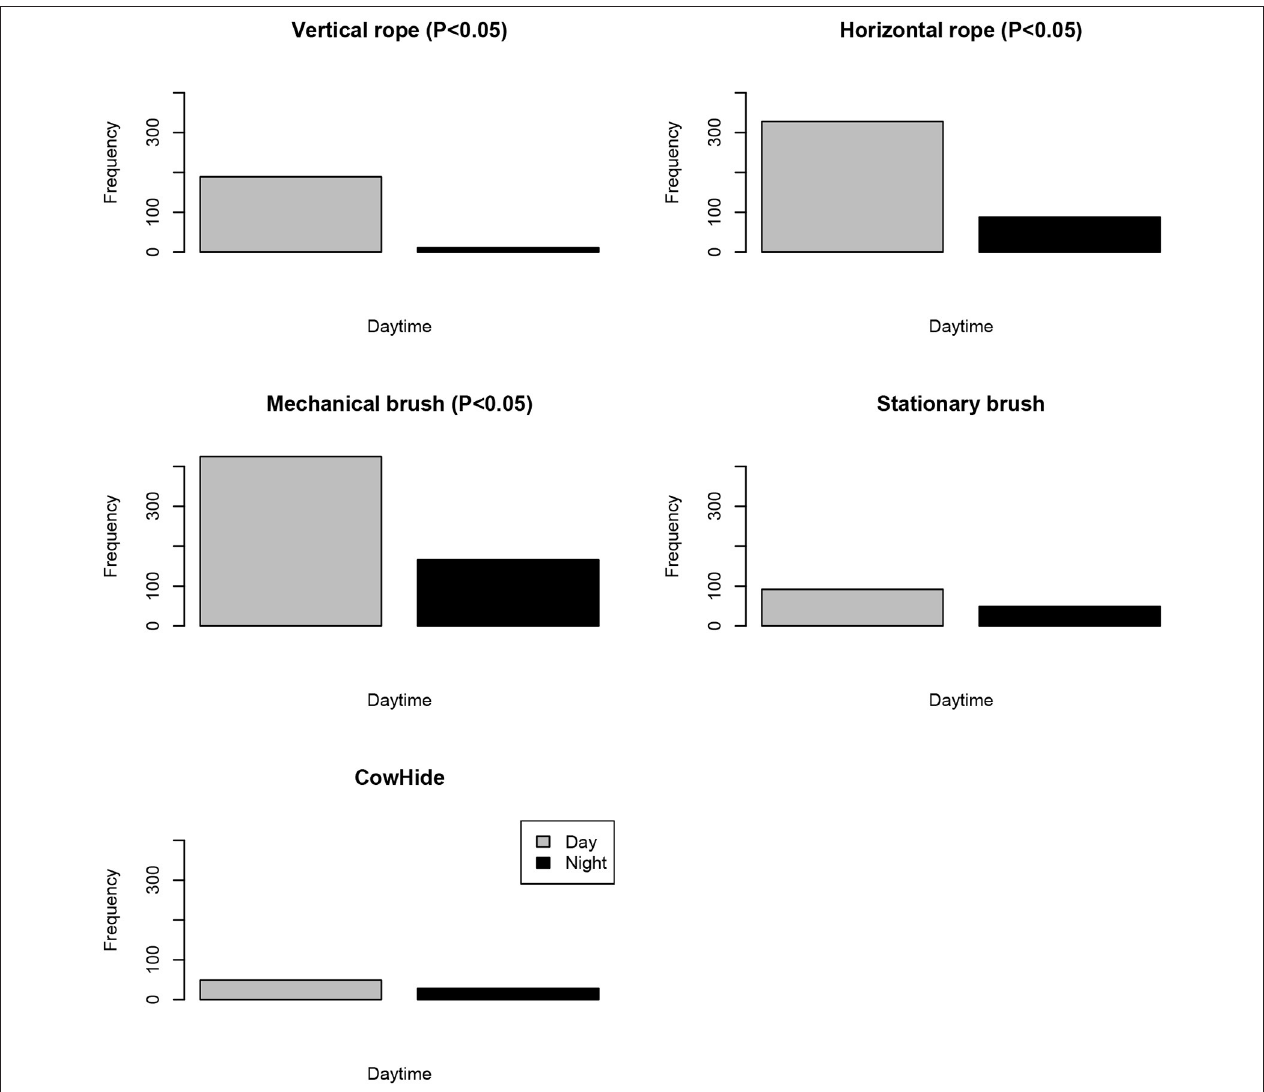
FIGURE 3 | Bout frequency of use (total number of bouts use/per time of the day) of five enrichment objects recorded continuously by day according to time of day (day/night) from preliminary analysis using five calves. Statistically significant differences between times of day are indicated ( P < 0.05).